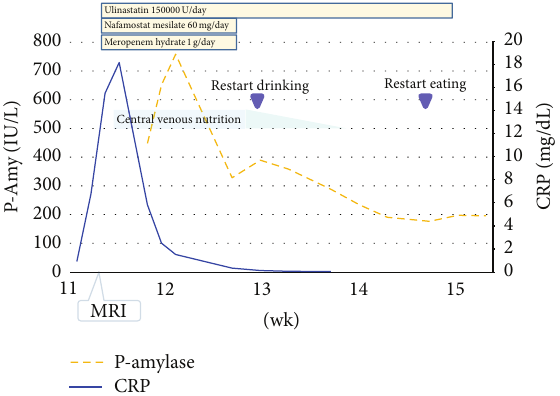
Figure 2: Clinography after hospitalization. Serum levels of CRP and pancreatic amylase (P-Amy) are shown. Medical interventions are shown in the